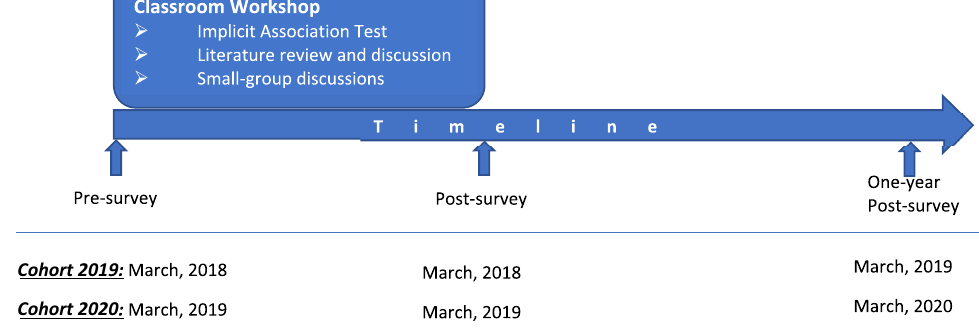
Figure 1. Implicit bias workshop schematic overview and